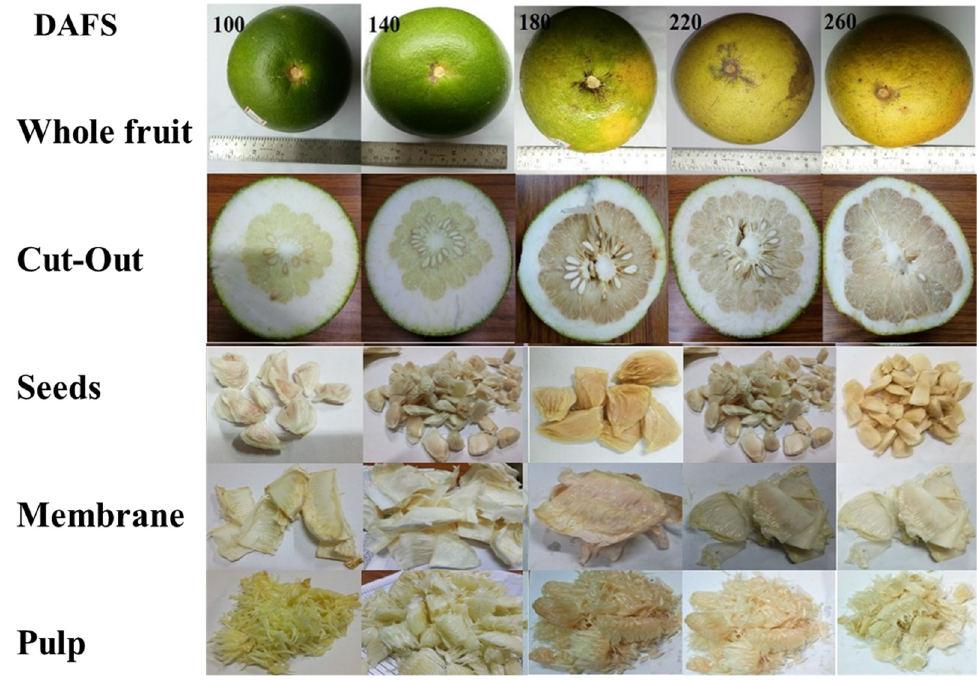
Figure 1. Pomelo fruit (whole; cut out section; and various parts of pomelo fruit at various maturity stages.